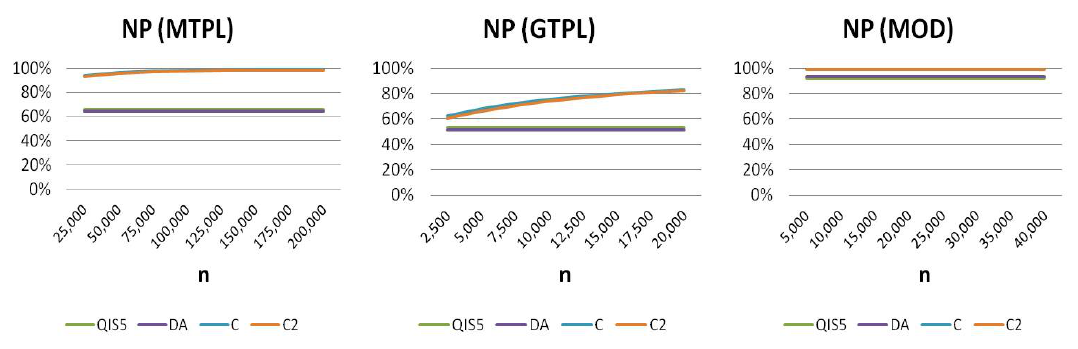
Figure 4. NP LoB according to several values of standard deviation of structure variable ( σ q ).